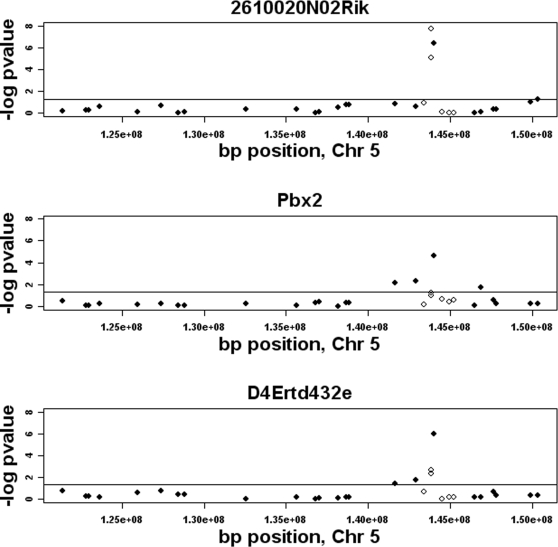
Fine mapping of the distal chromosome 5 locus.The three distant eQTL 2610020N02Rik (top), Pbx2 (middle), and D4Ertd432e (bottom) were fine mapped by typing additional markers in the region (open circles). Closed circles represent the original markers used in the whole genome association. The horizontal line corresponds to the nominal p-value of 0.05.